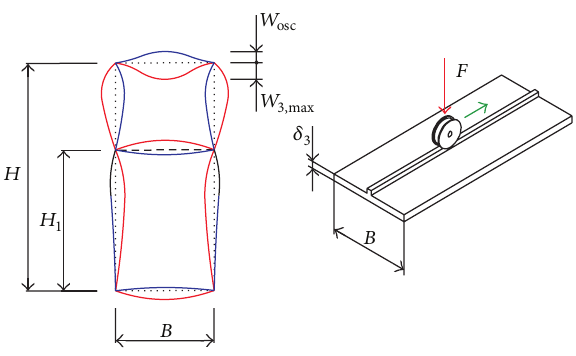
Figure 9: Oscillation of the girder elements due to the moving